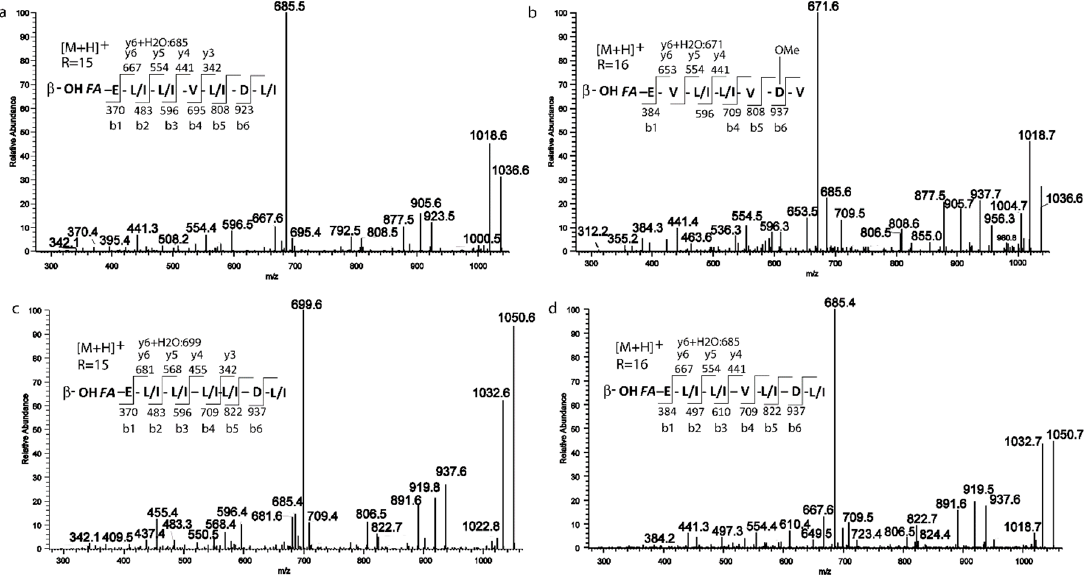
Figure 4. MS/MS spectra of the two isomers for the precursors ( a , b ) 1036.6 m / z ; ( c , d ) 1050.6 m / z .